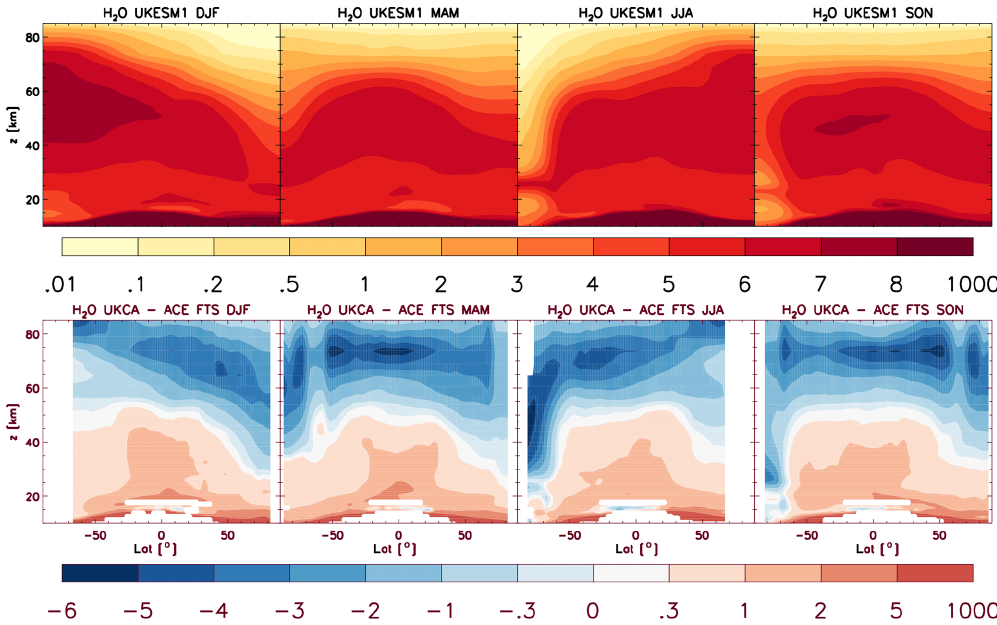
Figure 22. Same as Fig. 20 but for carbon monoxide (CO; ppm).